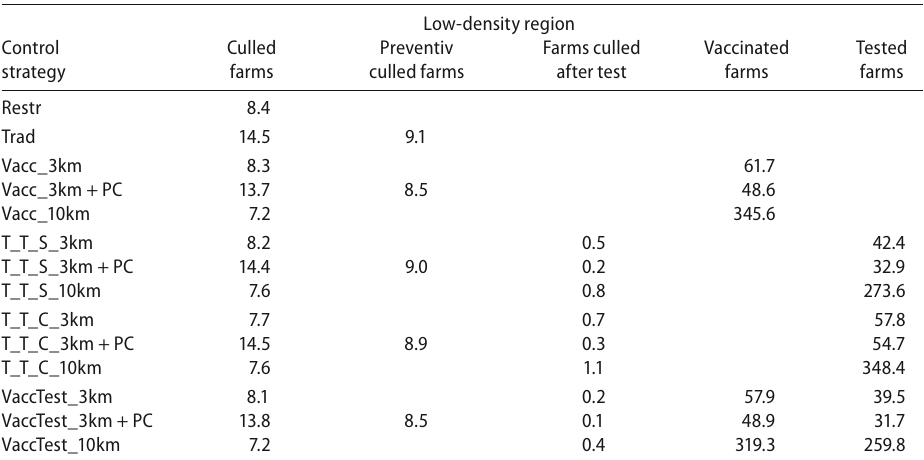
Table 4 Number of culled, thereof preventive culled respectively culled after a positive PCR result, vaccinated and tested farms for the low-density region